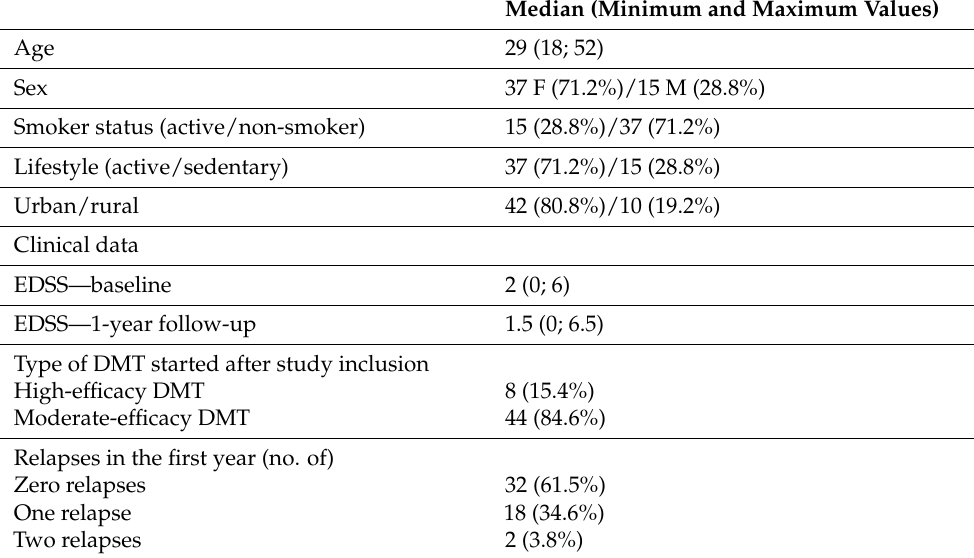
Table 1. Cohort demographics and main